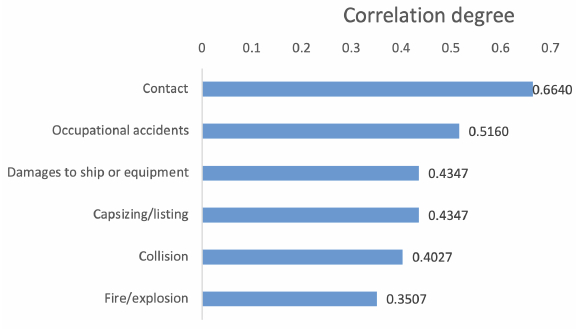
Fig. 3. Correlation of contributing factors